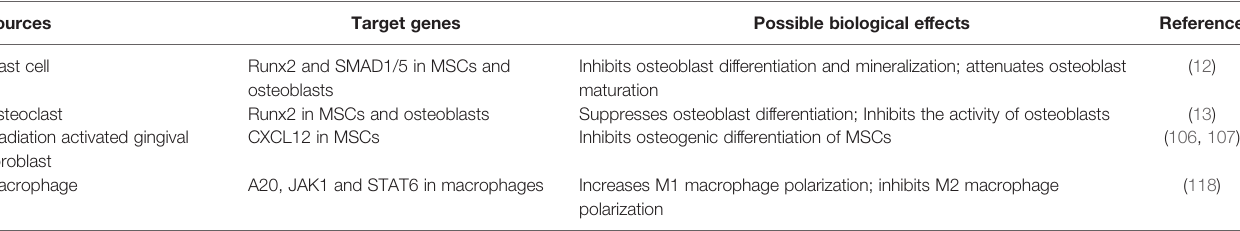
TABLE 2 | MiR-23a in bone